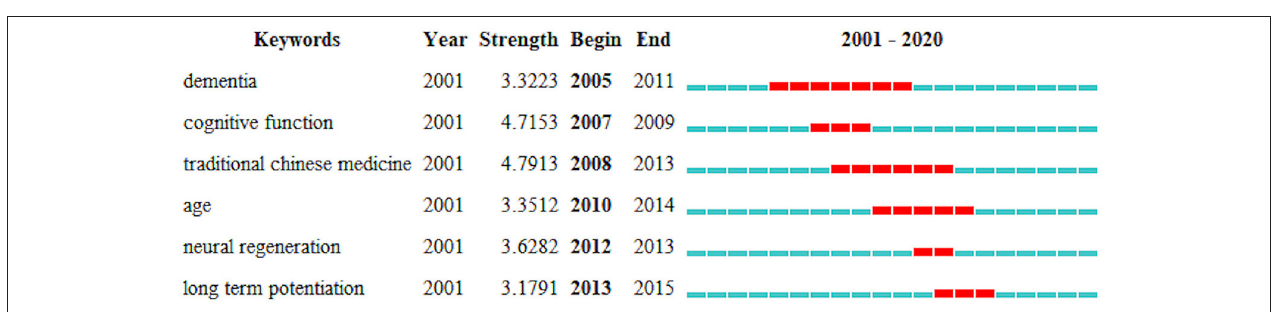
FIGURE 6 | Top six keywords with the strongest citation